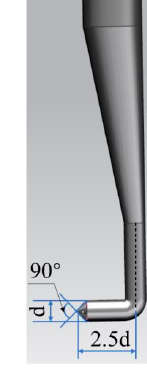
Figure 18. The schematic of the calibration setup of the five-hole probe.